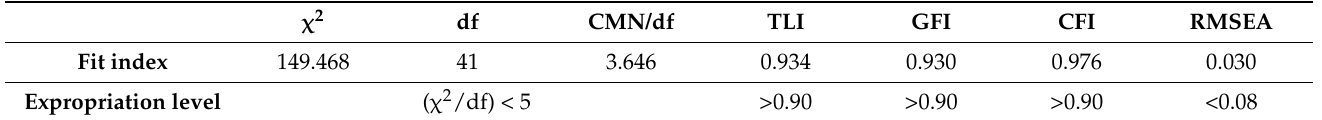
Table 4. Goodness of fit of total effect